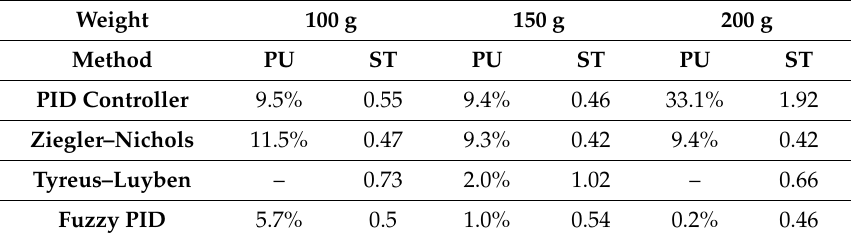
Table 7. Comparison of Experiment I. PU: percentage undershoot, ST: settling time.